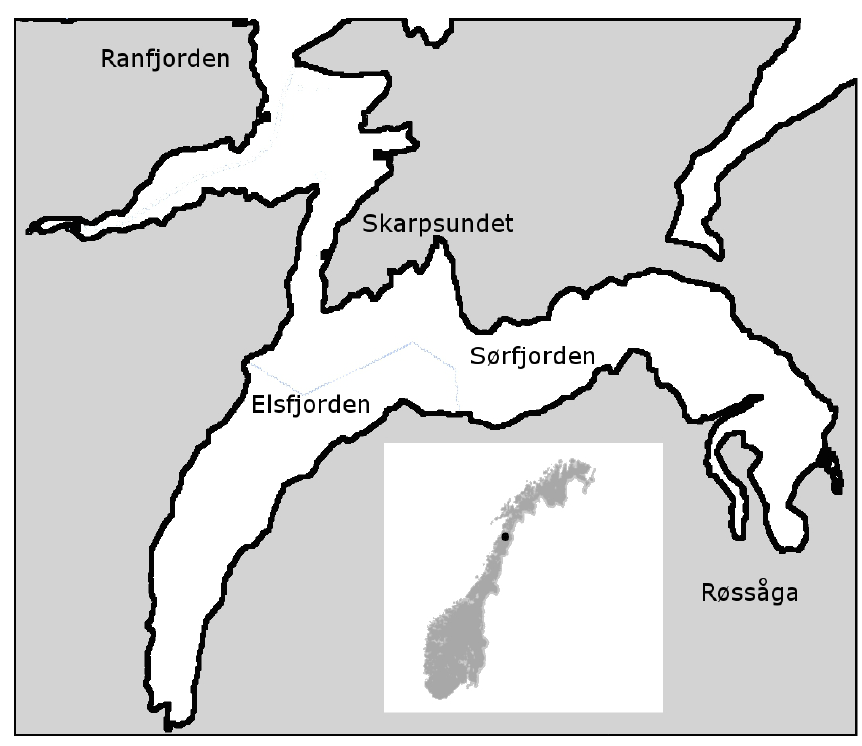
Figure 1. Overview map over Skarpsundet and surrounding fjords (map over Norway